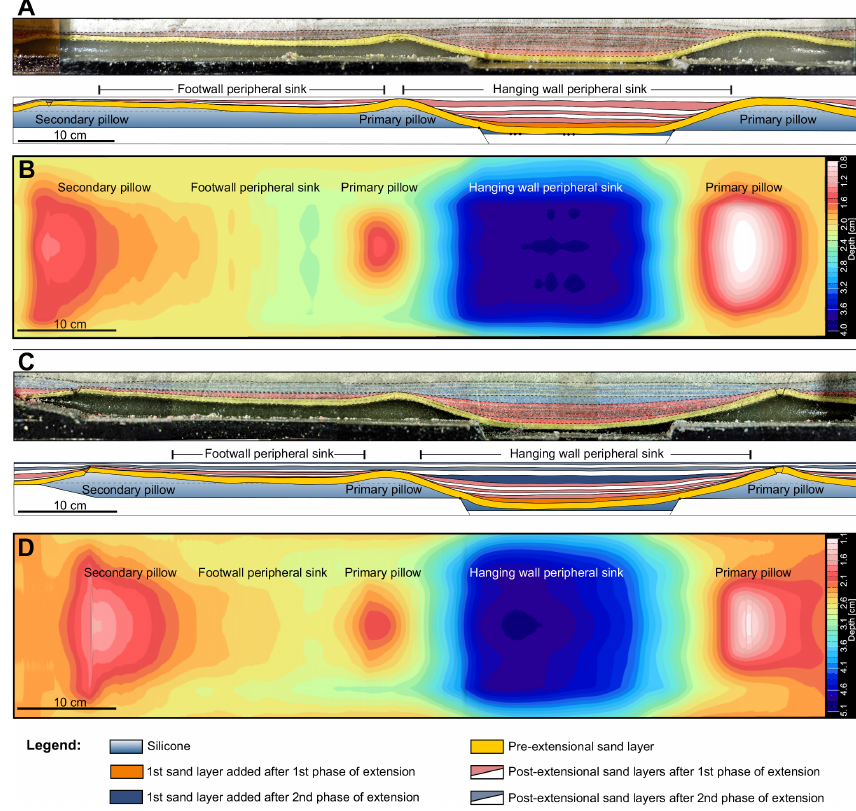
Figure 4. (a) Cross-section of reference Exp. 1a after 12 days. Post-extensional strata reveal the hanging wall peripheral sink (HPS) enclosed by two pillow-like silicone elevations. Additional sinks as well as an additional secondary pillow occur on the left side of the box. (b) Colour map displaying the depth of the top of the silicone layer related to the final surface from Exp. 1a. The diameters of the pillows are smaller than the diameter of the HPS. (c) Cross-section of reference Exp. 1b after 18 days, in which an additional phase of extension was applied after 10 days. The crests of the pillows are slightly faulted. (d) Depth map of the top of the silicone layer from Exp. 1b showing that the pillow structures are